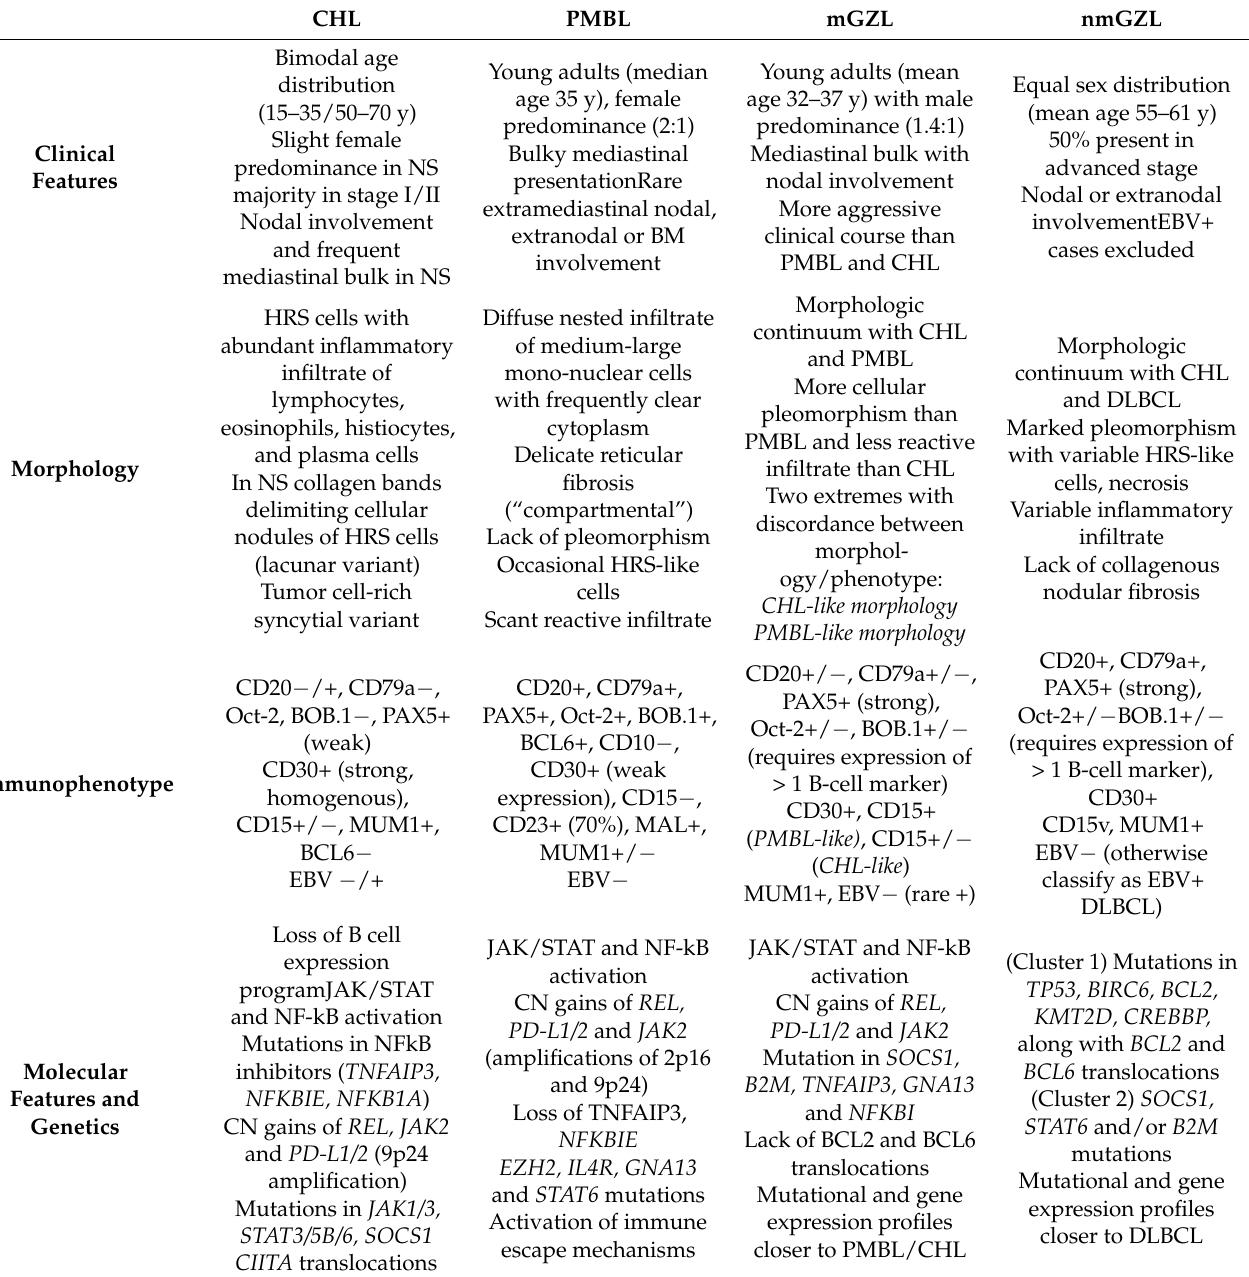
Table 2. Comparison of clinico-pathological features of CHL, PMBL, mGZL and